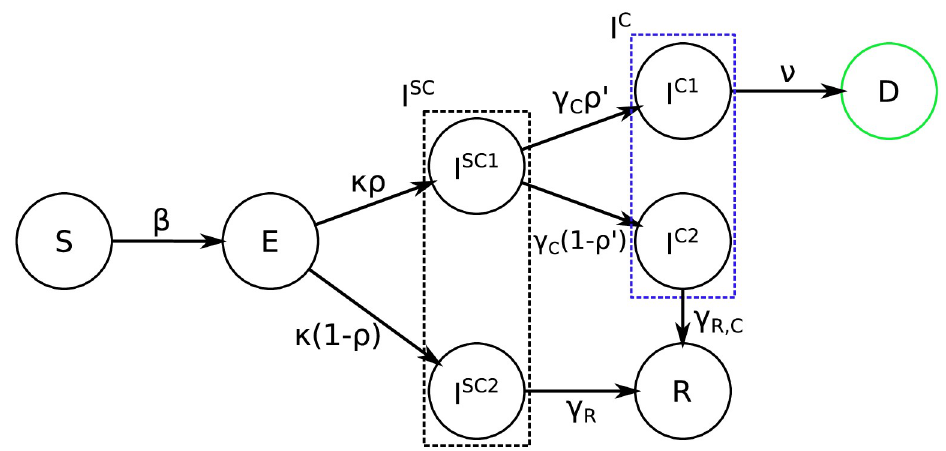
Fig 2. Graphical representation of the model, for each age group. The green color represents a compartment that is observed independently for each age group, while blue represents a compartment whose sum across age groups is